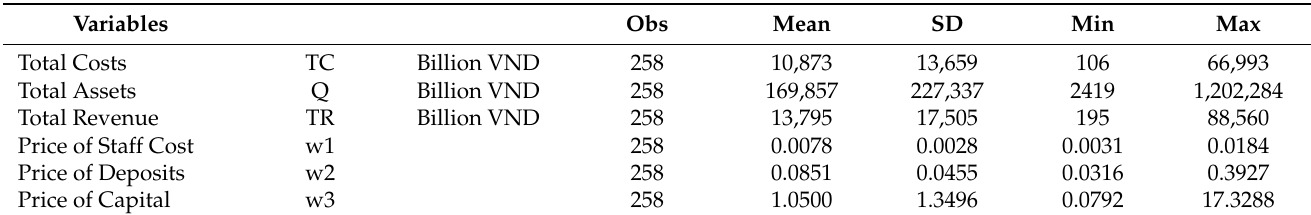
Table A4. The financial data used to compute the Lerner index of Vietnam banks (2008–2017).